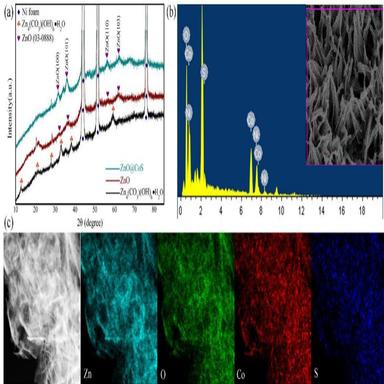
(a) XRD patterns of the ZnO precursor, ZnO and ZnO@CoS; (b) EDX images of the ZnO@CoS; (c) Transmission mapping images of the ZnO@CoS.